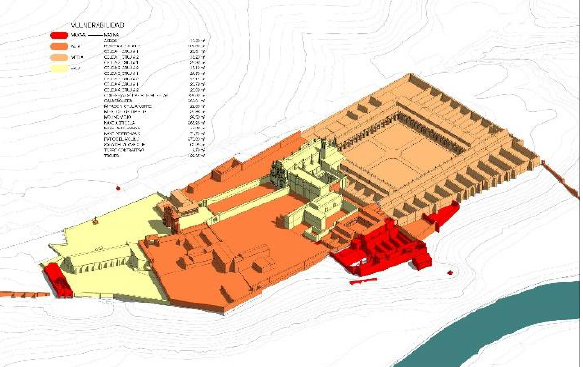
Figure 6: Vulnerability view. HBIM Charterhouse of Jerez, phase 15, Sisters of Bethlehem